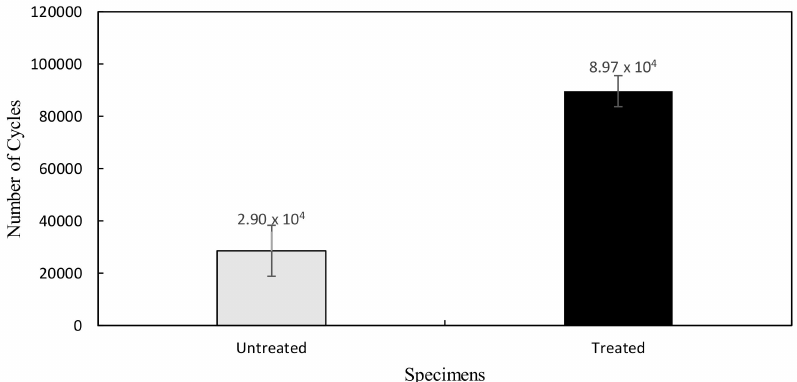
Figure 8. Average fatigue life of treated and untreated Ti-6Al-4V specimens tested at 400 MPa.